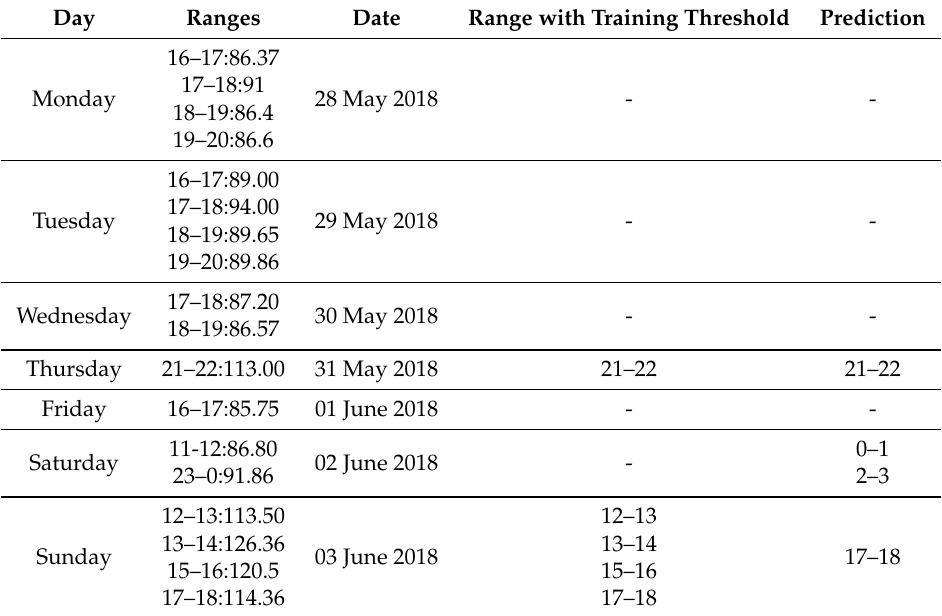
Table 5. Validation week from 28 May to 3